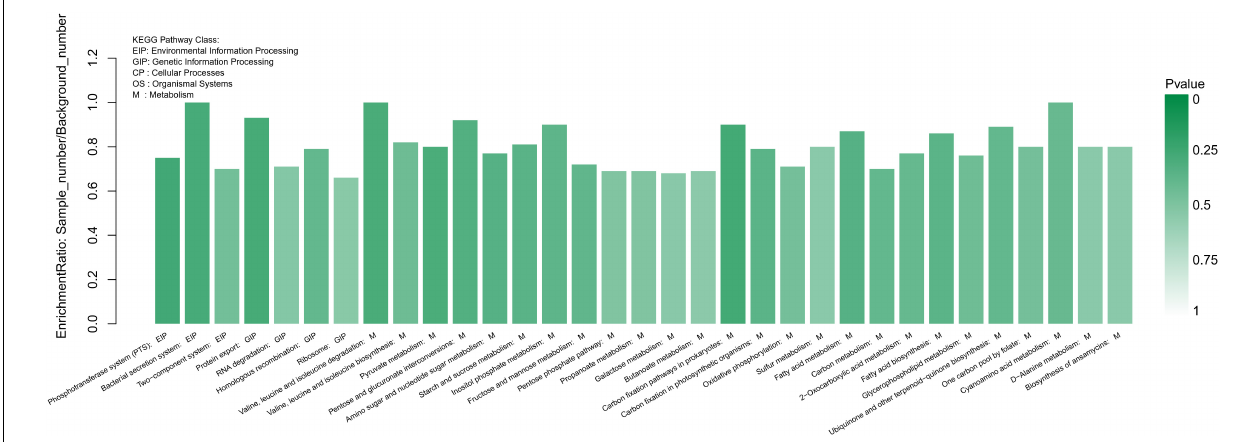
FIGURE 8 | Statistical enrichment of differentially expressed genes in KEGG pathways. Genes were annotated in five main categories: Environmental Information Processing (EIP) pathway, Genetic Information Processing (GIP) pathway, Cellular Processing (CP) pathway, Organismal Systems (OS) pathway and Metabolism (M) pathway. The green color represented the p -value as shown on the right side, the darker color meant the more significant.